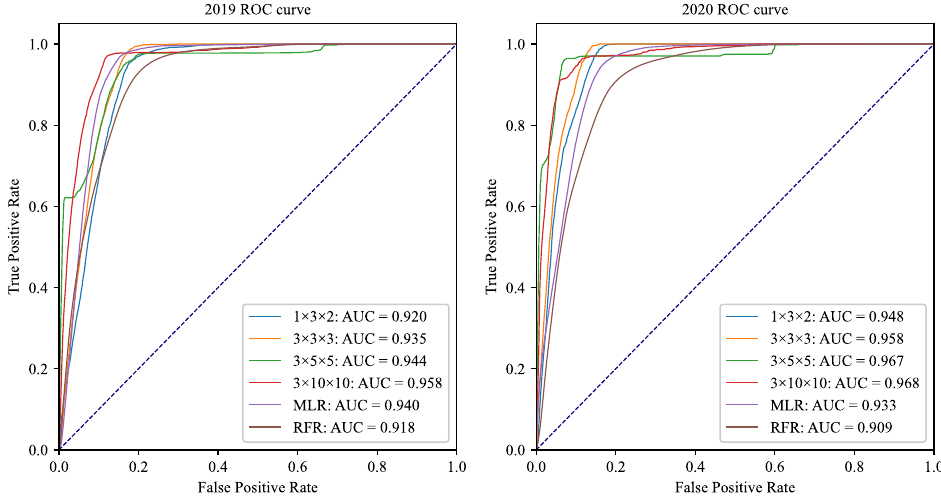
Figure 7. ROC curves of SWTSA for different rank sizes (AUC: Area Under